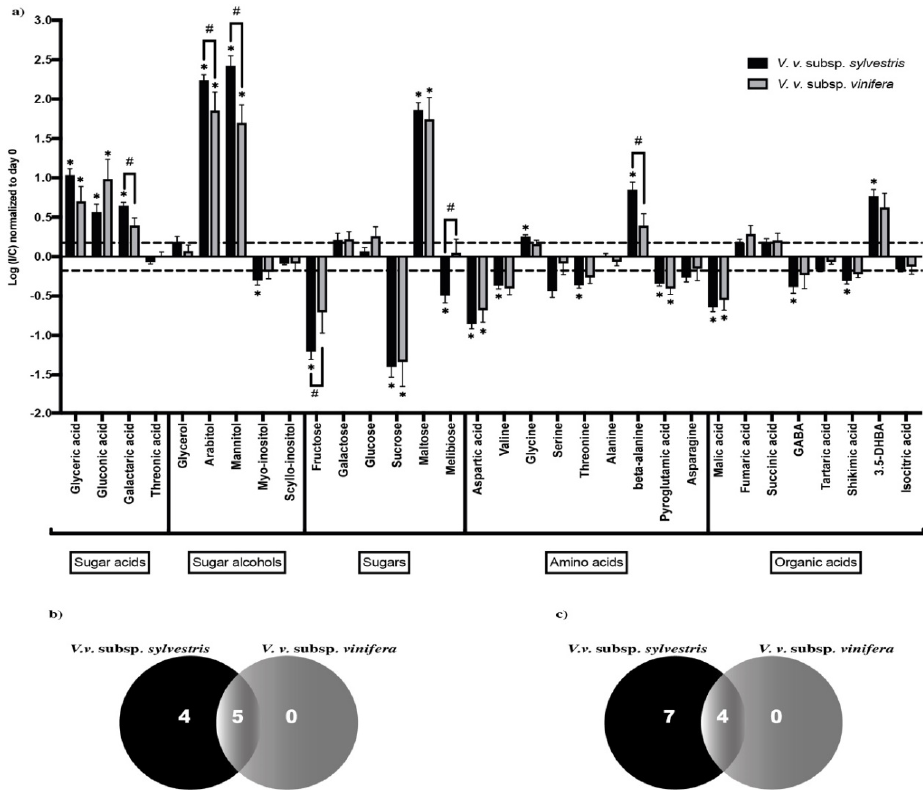
Figure 3. Changes in primary metabolite contents at seven DPI. ( a ) Contents are expressed as the log of the ratio between content (normalized to T0) in inoculated sample (I) and content in mock-inoculated control sample (C). Metabolite contents are represented in black for V. v. subsp . sylvestris and in gray for V. v. subsp . vinifera . * means a statistically significant difference between I and C (fold change at least ± 1.5 and p < 0.05). # represents a (I/C) statistically significantly different between V. v. subsp . sylvestris and V. v. subsp . vinifera ( p < 0.05). Error bars represent standard error of the mean. ( b ) Venn diagram of metabolites increasing significantly between I and C (fold change at least ± 1.5 and p < 0.05) in black for V. v. subsp . sylvestris and in gray for V. v. subsp . vinifera . ( c ) Venn diagram of metabolites decreasing significantly between I and C (fold change at least ± 1.5 and p < 0.05), in black for V. v. subsp . sylvestris and in gray for V. v. subsp . vinifera.